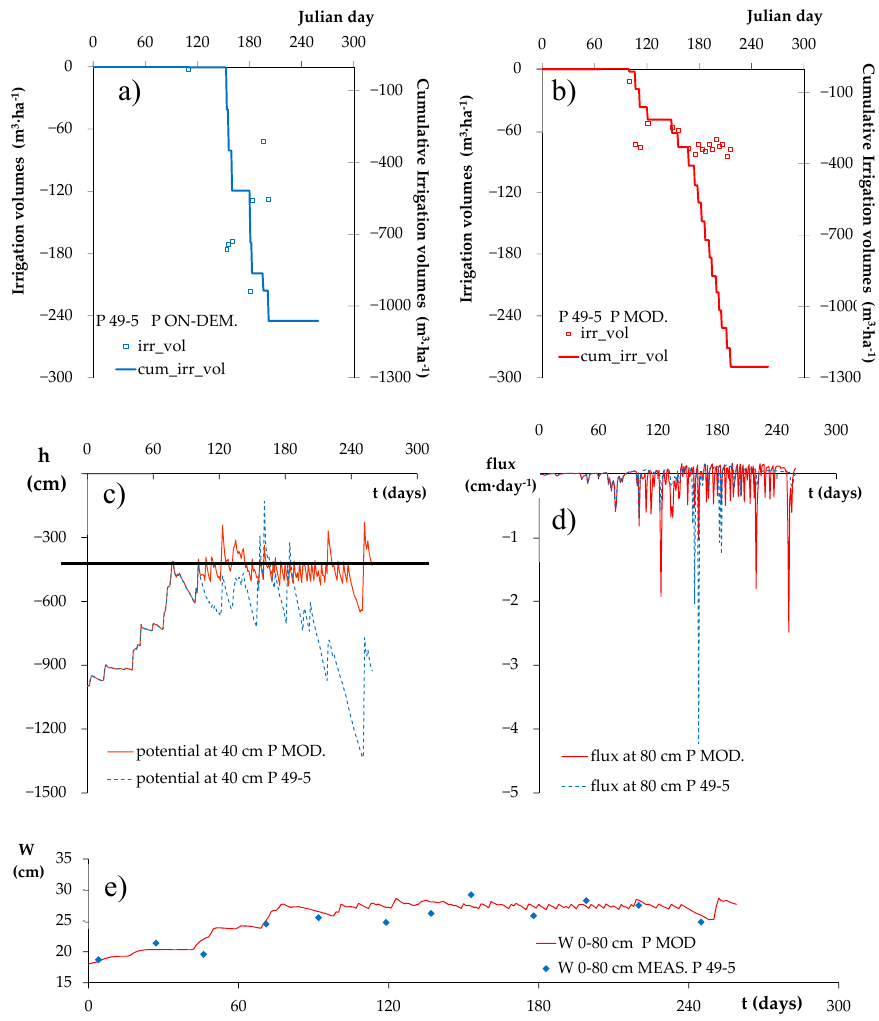
Figure 10. FARM P 49-5. ( a ) Irrigation volumes (both per single day and cumulative) calculated by the model (MOD); ( b ) irrigation volumes actually supplied by the farmer (ON-DEM); ( c ) the pressure head at 40 cm depth; ( d ) the percolation fluxes at 80 cm; ( e ) comparison between the time evolution of the water storage predicted by the model (MOD) and that estimated starting from the EMI sensor ECa readings (MEAS).